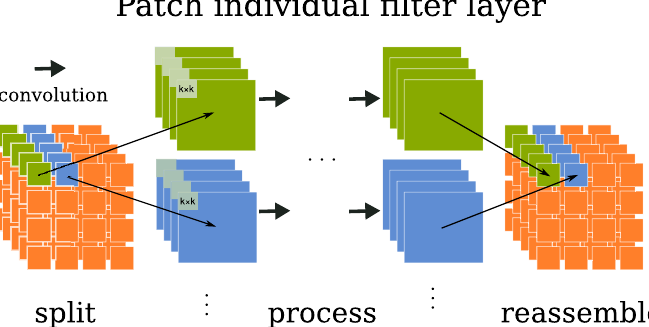
Figure 4. Depiction of a patch individual filter (PIF) layer in 2D. In this setting, inputs are 5 feature maps from a previous layer. Each feature map is being split into 16 patches and convolutions are applied patch-wise. Finally, the feature maps are reassembled in the same